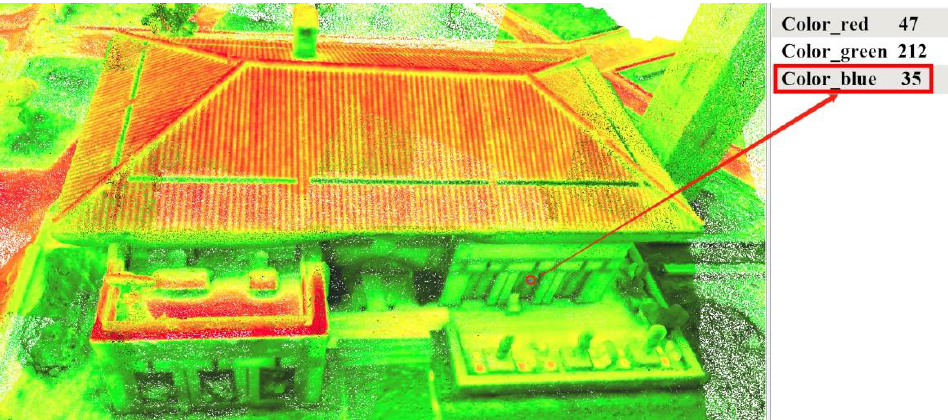
Figure 13. The 3D thermal infrared (TIR) model.